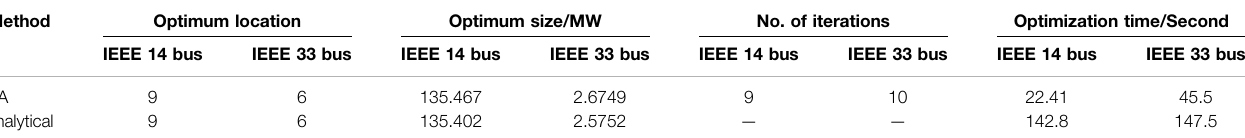
TABLE 2 | Comparison of optimal size and computation time for both networks.